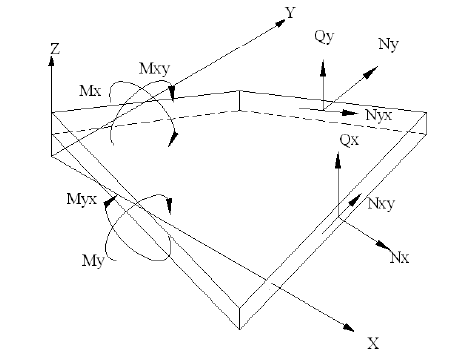
Figure 3: Generalized force and moment